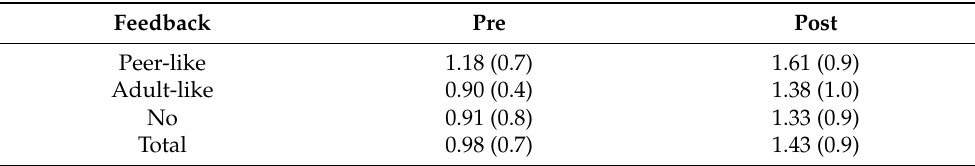
Table 5. The children’s average word knowledge scores on the pre-test and post-test for the three conditions (SD between